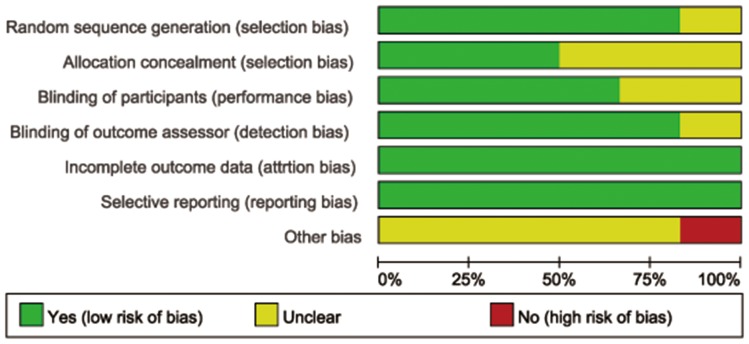
Risk of bias graph.